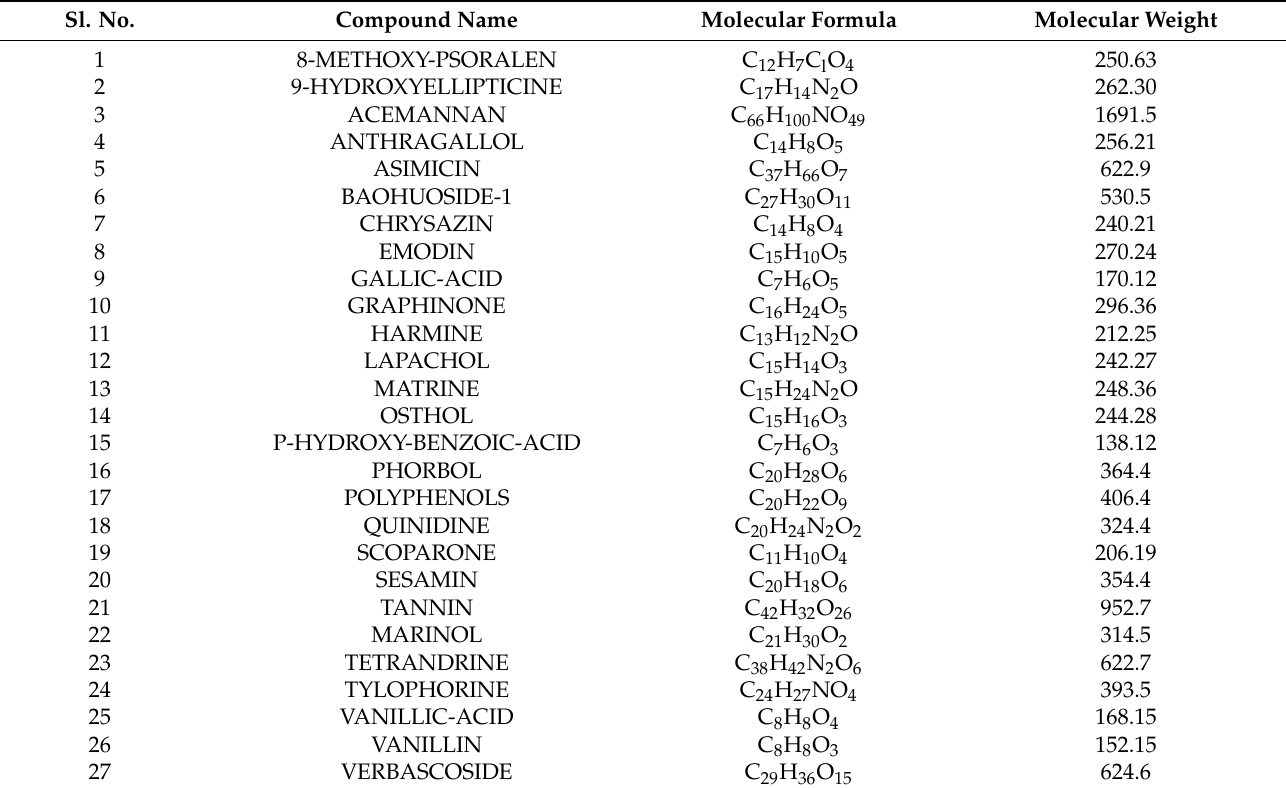
Table 2. Immunomodulatory small molecules from the SuperNatural III database managed by Charite